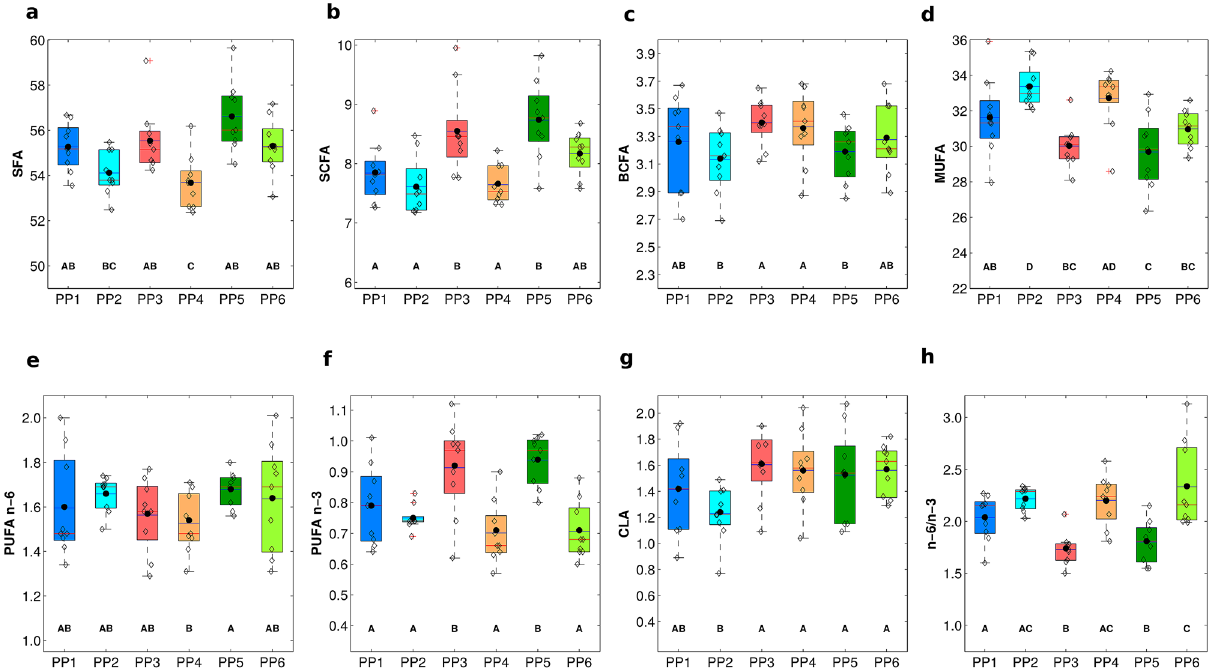
Figure 7. Box-plot of contents of the fatty acids composition for each Pasture area-Producer: ( a ) SFA, total saturated fatty acids; ( b ) SCFA, short chain fatty acids; ( c ) BCFA, branched chain fatty acids; ( d ) MUFA, total monounsaturated fatty acids; ( e ) PUFA-n6, total polyunsaturated fatty acids n-6; ( f ) PUFA-n3, total polyunsaturated fatty acids n-3; ( g ) CLA, conjugated linoleic acid; ( h ) ratio n6/n3. Rhombus refer to HR cheese replicates. A mean value relative to cheese samples collected is indicated for comparison (dotted line). Data expressed as least square mean ± standard error of mean. A–D Values between the boxplot of each compounds with different superscript letters differ significantly at P < 0.01. Fatty acids were grouped in: SFA (C4 + C6 + C8 + C10 + C12 + C13 + C14 + C15 + C16 + C17 + C18 + C19 + C20), SCFA (C4 + C6 + C8 + C10), BCFA (iC14 + iC15 + aiC15 + iC17 + aiC17 + iC18), MUFA (C10:1 + C12:1 + C14:1 + C15:1 + C16:1 + C17:1 + C18:1 + C20:1), PUFA n-6 (C18:2c9,c12) PUFA